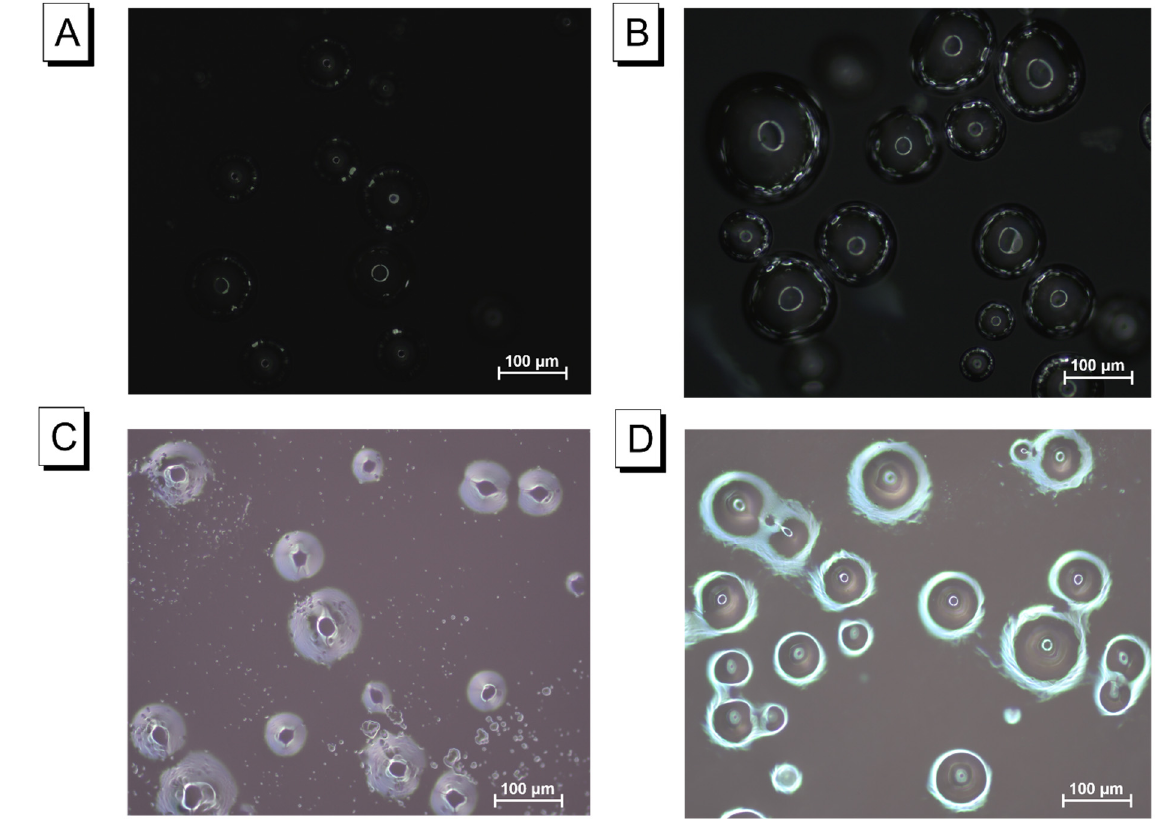
Figure 4 . Optical microscopy images for the reflection mode in the darkfield. AAm–Alg hydrogel film + TC426: ( A ) without VFD; ( B ) with VFD, 100 μ m; carrageenan hydrogel film + TC426: ( C ) without VFD; ( D ) with VFD, 100 μ m; HSA = 2000 mg/L and TC426 = 10 μ M, VFD was used for 2 and 4 min in AAm–Alg + TC426 and carrageenan + TC426, respectively.